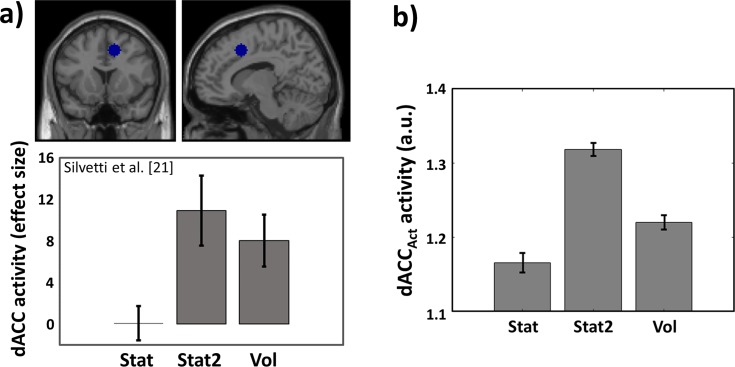
Simulation 1: Results comparison with fMRI data.a) Outcome-locked activation of human dACC (with 90% CI, extracted from the ROI indicated by the blue sphere; MNI: [12,14,44]) in a RL task executed during fMRI scanning. Data extracted by WebPlotDigitizer from Fig 4 in ref. [21]. The ROI is a local maximum within the cluster with the highest z value. The task was performed in the same three environments we used in our simulations. dACC activity peaked in Stat2 and not in Vol condition (Stat2 > Vol, p < 0.05), indicating responsiveness to overall uncertainty (i.e. PE) rather than to volatility (see ref. [21] for further details) b) dACCAct average activity (sum of PE units activity ± s.e.m.; see Eq 1 and Equations S3-S4 in S1 File) as a function of environmental uncertainty. Differently from the LC, the dACCAct is maximally active in stationary uncertain environments (Stat2), indicating that due to PE computation, dACCAct (like the human dACC) codes for overall uncertainty rather than for volatility.